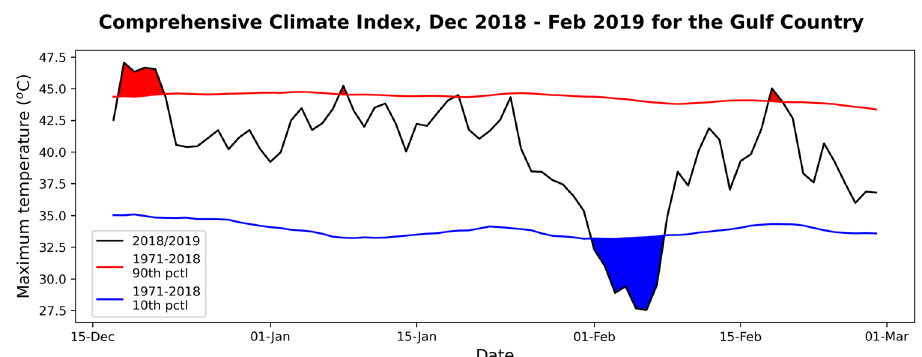
Figure 7. Comprehensive climate index over the inland Gulf region in late 2018/early 2019. Area-averaged comprehensive climate index (black line) over the Gulf region from late December 2018 to late February 2019, with a multi-year daily 10th and 90th percentile for 1971–2018 (blue and red lines, respectively) and days below/ above the percentile (blue/red shading). The index has been calculated using maximum daily temperatures, daily maximum relative humidity, daily averaged wind speed, and daily-averaged solar radiation using the adjustment factors and equations listed in Mader et al. 26